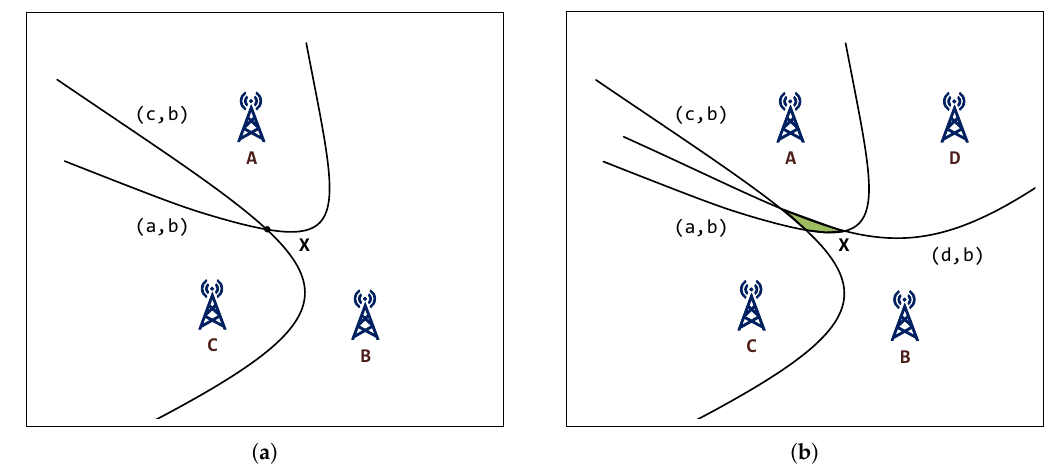
Figure 5. Illustration of a position estimation using TDoA. ( a ) TDoA—3 receivers. ( b ) TDoA—4